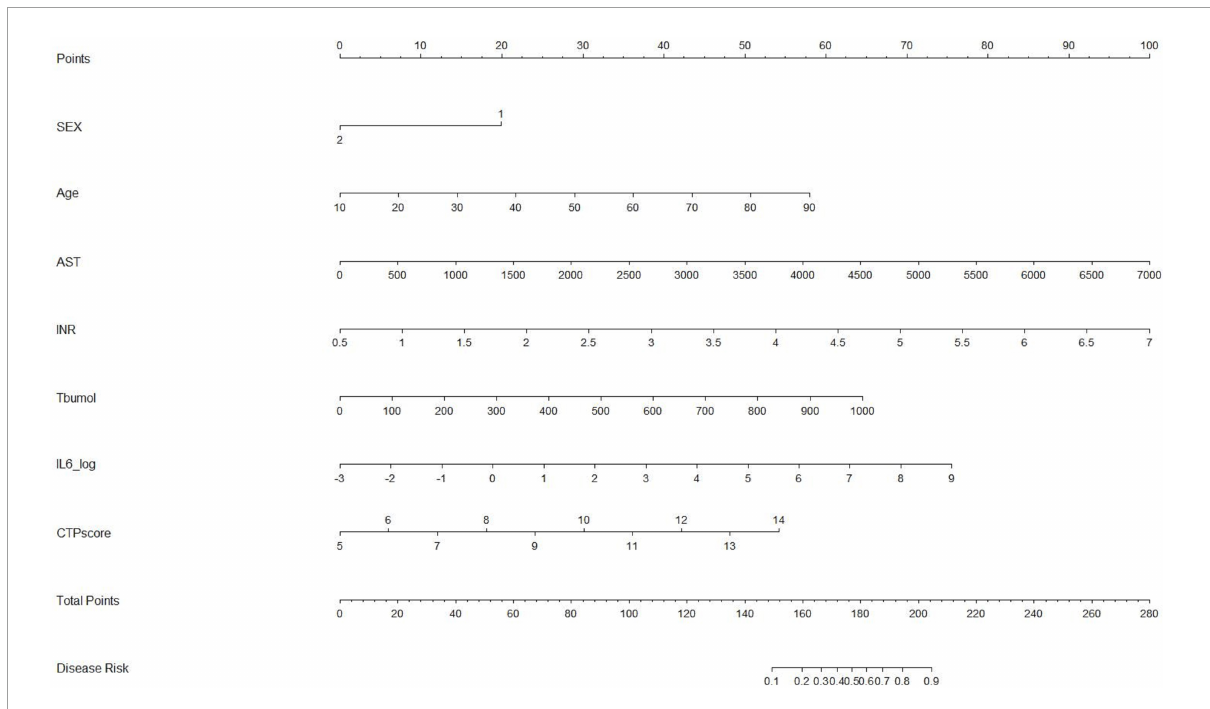
FIGURE3 Nomogram for predicting 28-day mortality of LF patients.